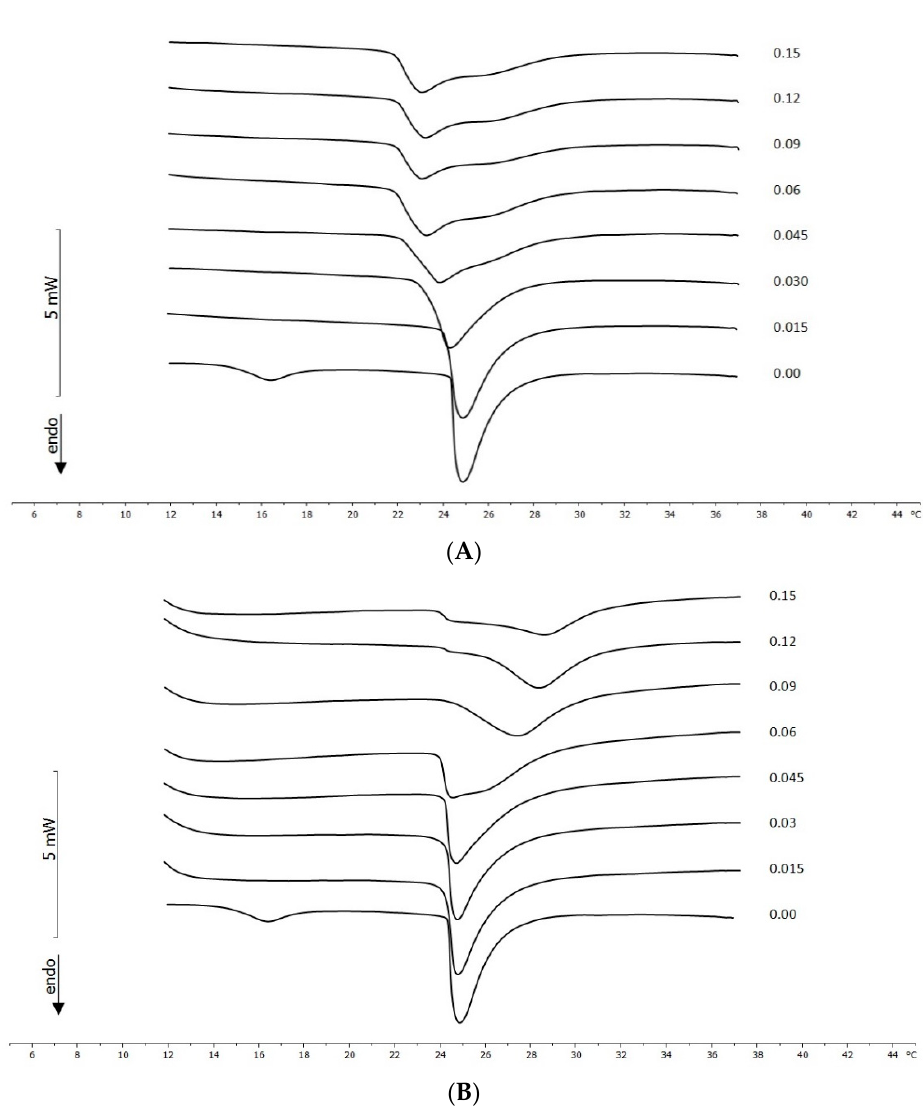
Figure 3. ( A ) Calorimetric curves, in the heating mode, of MLVs prepared with different molar fractions of GA. The labels at the right side of each curve represent the molar fraction of GA. ( B ) Calorimetric curves, in the heating mode, of MLVs prepared with different molar fractions of SG. The labels at the right side of each curve represent the molar fraction of SG.